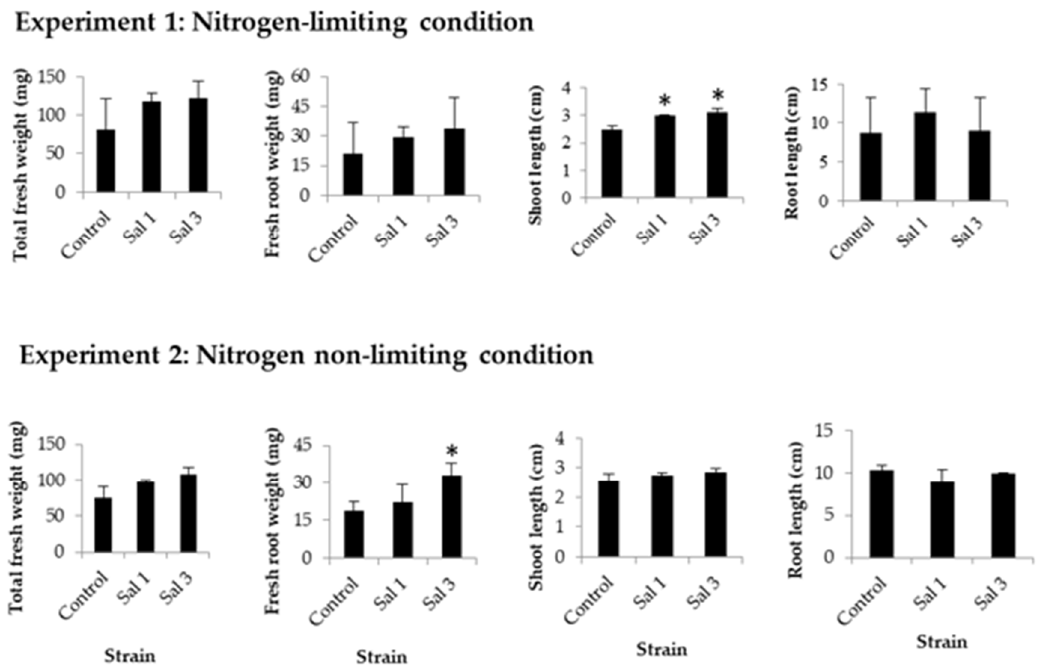
Figure 6. The effect of inoculation of sweet potato endophytes on the growth of tomato plants in nitrogen-limiting (Experiment 1) and non-limiting (Experiment 2) conditions in liquid media tubes. The bars represent standard deviation ( n ≥ 3) and asterisks indicate a significant difference at P < 0.05 by Tukey’s test.